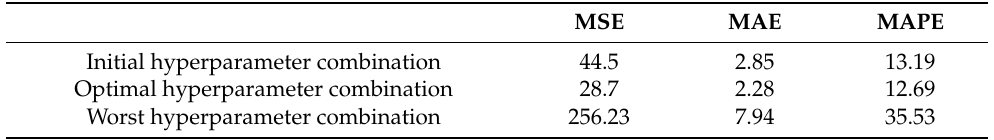
Table 6. Prediction and evaluation index of the algorithm for the radius of curvature after springback of fixed-curvature forming based on